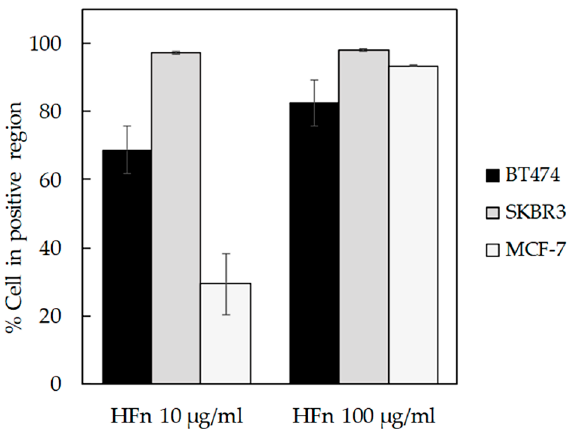
Figure 1. HFn recognition of BC cells. BT474, SKBR3, and MCF-7 cells were incubated for 1 h at 37 °C